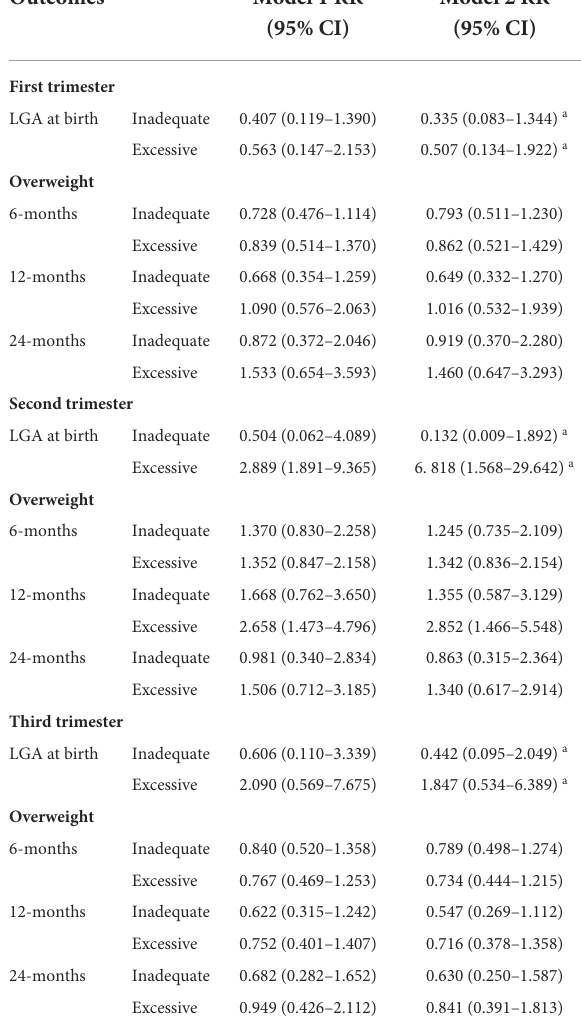
TABLE 4 Unadjusted and adjusted correlations between trimester GWGRs and birthweight and age-specific BAZ. Outcomes